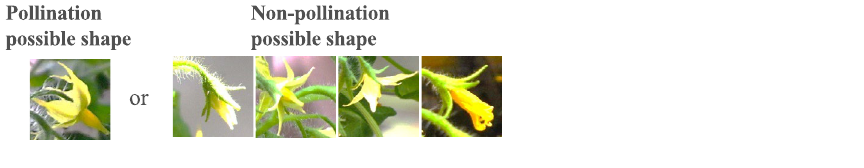
Figure 5. A two class classification system.